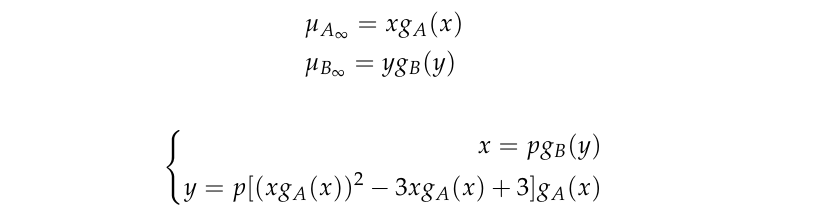
Table 2. The Fraction of Working Nodes of the Network A and B